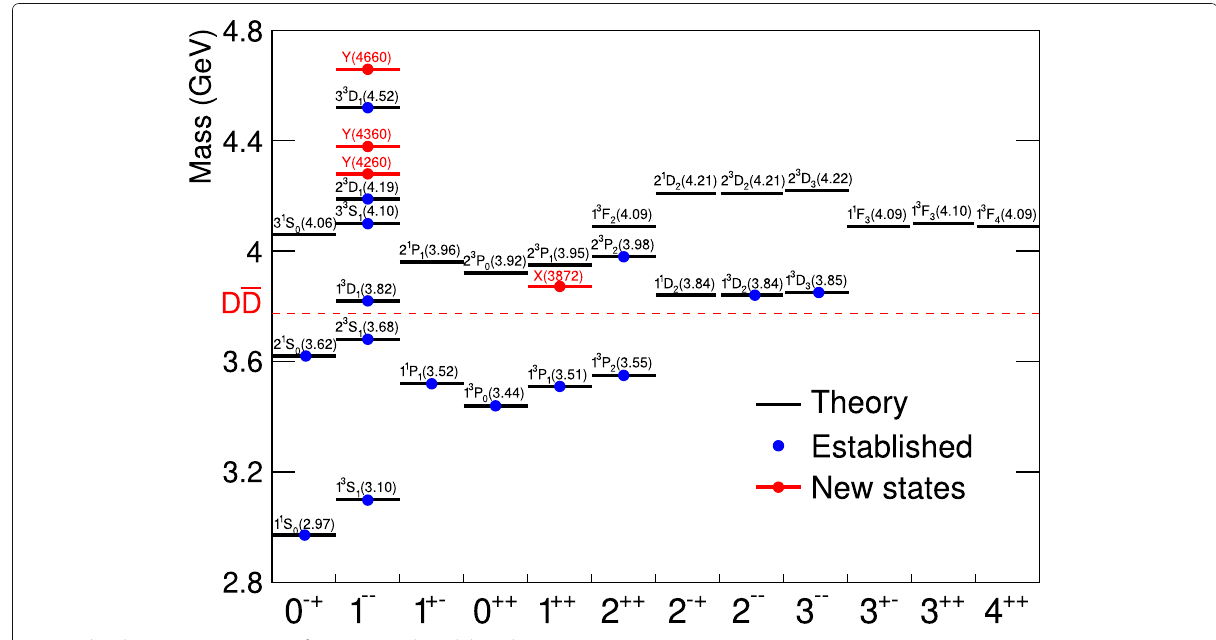
Fig. 2 The charmonium spectrum from potential model prediction